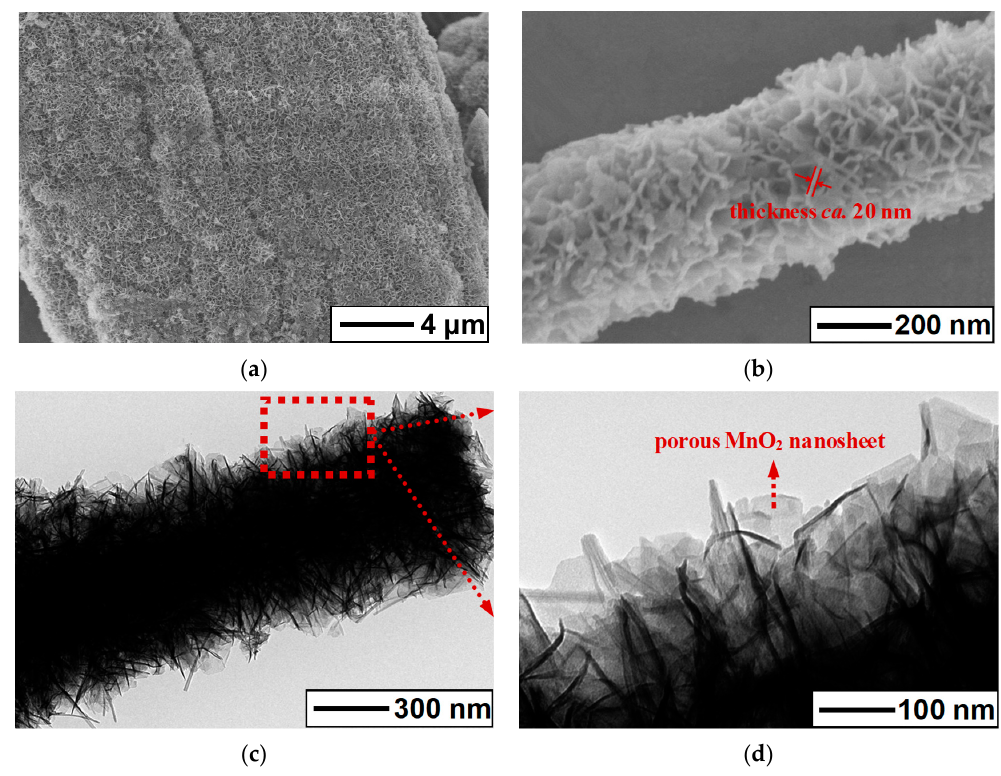
Figure 1. Electron micrographs of the cellulose-derived MnO 2 -TiO 2 -carbon-47.28% composite. ( a ) FE-SEM image of the composite showing nanofiber assemblies; ( b ) an individual composite material separated from the assemblies; ( c ) TEM image of an individual MnO 2 -TiO 2 -carbon-47.28% composite; ( d ) partially magnified TEM image (marked by the red frame) showing the MnO 2 nanosheets with porous structures.